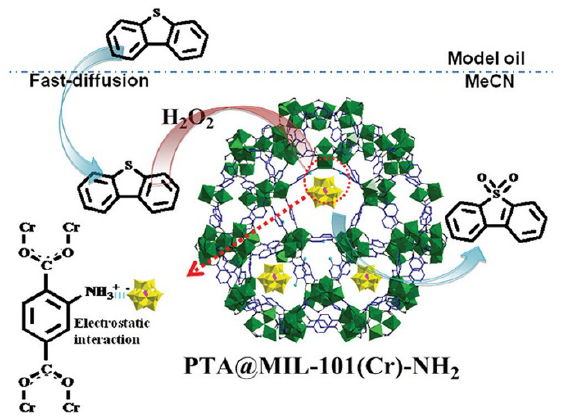
Figure 13. Schematic description of the extractive and catalytic oxidative desulfurization (ECODS) process using PTA@MIL-101(Cr)-NH 2 as the catalyst. Reproduced with permission from RSC, 2014